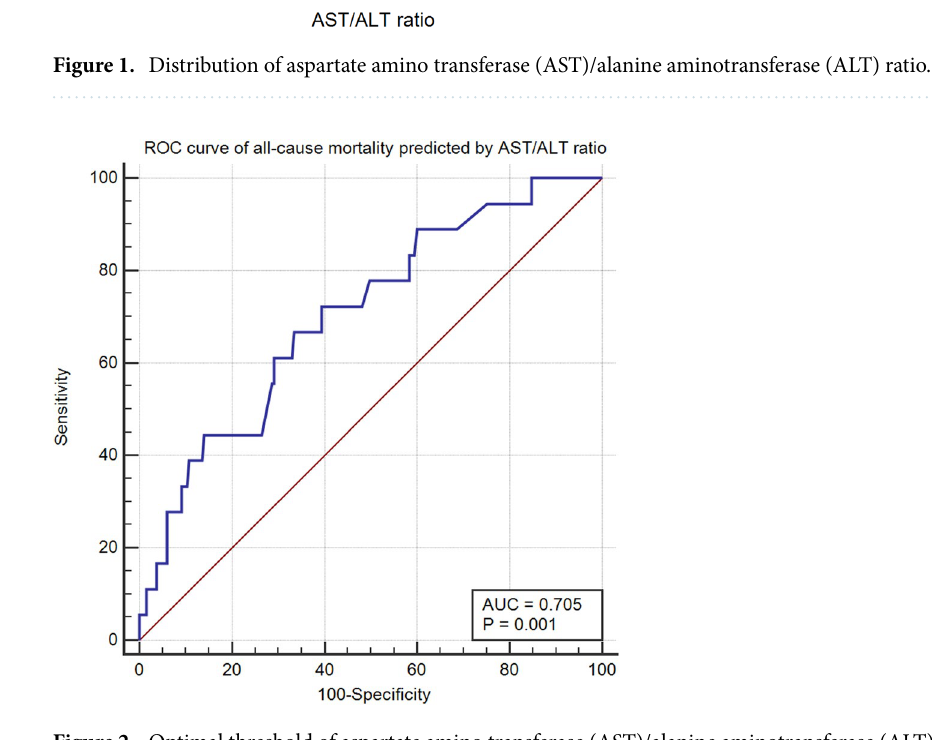
Figure 2. Optimal threshold of aspartate amino transferase (AST)/alanine aminotransferase (ALT) ratio for predicting all-cause